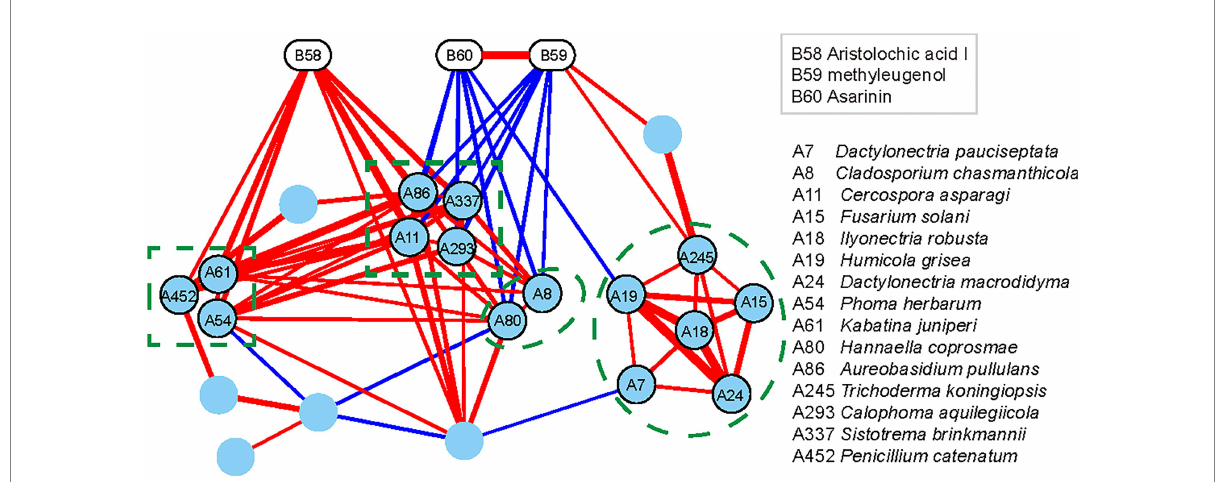
FIGURE 3 Interaction network of differential functional groups in different niches of A. heterotropoides . Pearson correlation between the contents of the three active ingredients and the relative contents of the endophytic fungi in different niches of A. heterotropoides . Endophytic fungi with significant correlation ( p < 0.05) were used as nodes to construct the interaction network and visualization in Cytoscape. Red lines indicate a positive correlation, whereas blue lines indicate a negative correlation. Line width is proportional to the values of Pearson correlation coefficient. Raw data is provided in the EXCEL